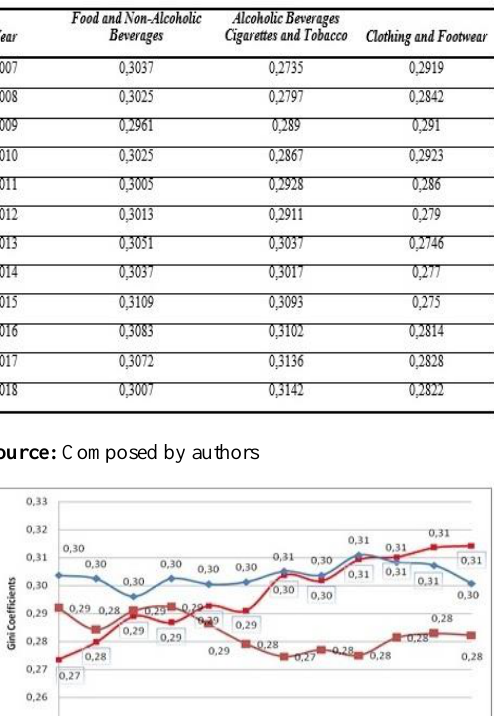
Table 1: Gini Coefficients of Expenditure Categories for Food and Non-Alcoholic Beverages, Alcoholic Beverages, Cigarettes and Tobacco and Clothing and